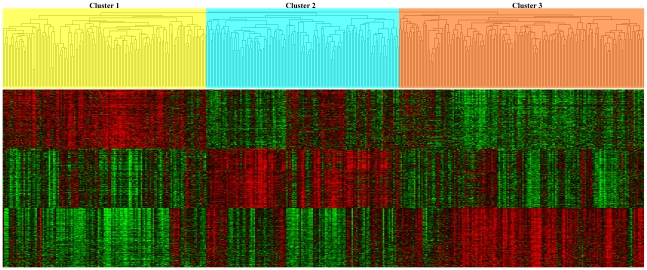
Hierarchical clustering yields three distinct groups.Hierarchical clustering of all 432 lung adenocarcinomas (AD) which shows three main groups of tumors denoted by yellow, blue and orange in the dendrogram. Below is a heat map that represents the 200 genes that are most highly correlated to the left most cluster followed by the middle cluster and the right most cluster. Red indicates relative over-expression (compared to the median) while green indicates relative under-expression.